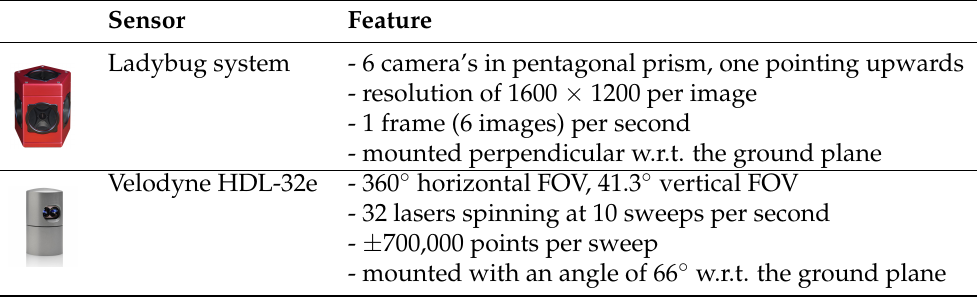
Figure 3. An image acquired by stitching the six images of the Ladybug together. The image shows the starting point of a video sequence captured at the Dow chemical company. Table 1. A summary containing the main features of the acquisition